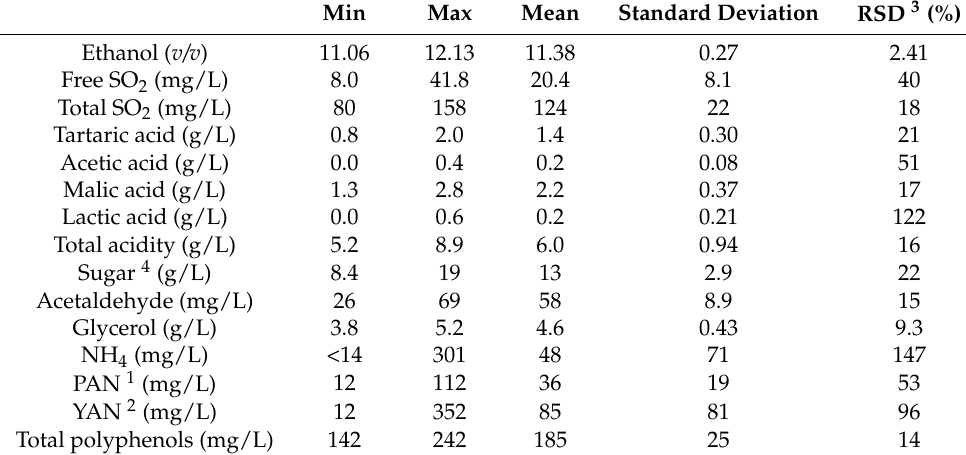
Table 2. Base enological